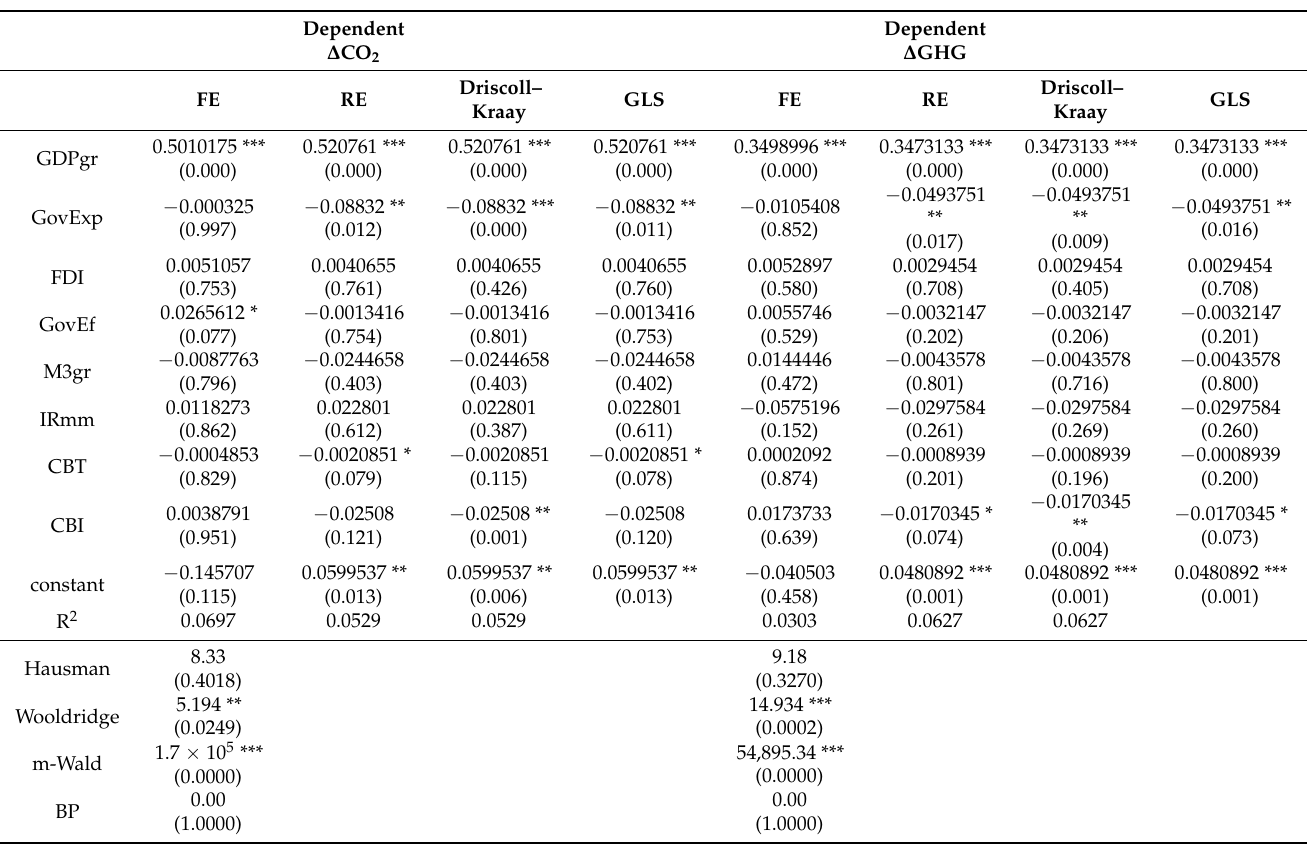
Table 4. All countries’ CO 2 and GHG